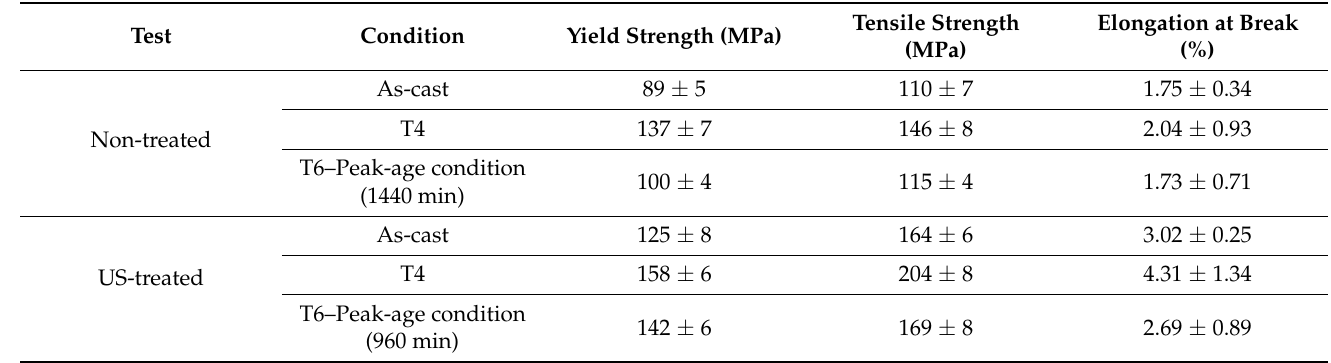
Table 2. Mechanical properties of the non- and US-treated material in the as-cast, solution-treated and peak-aged